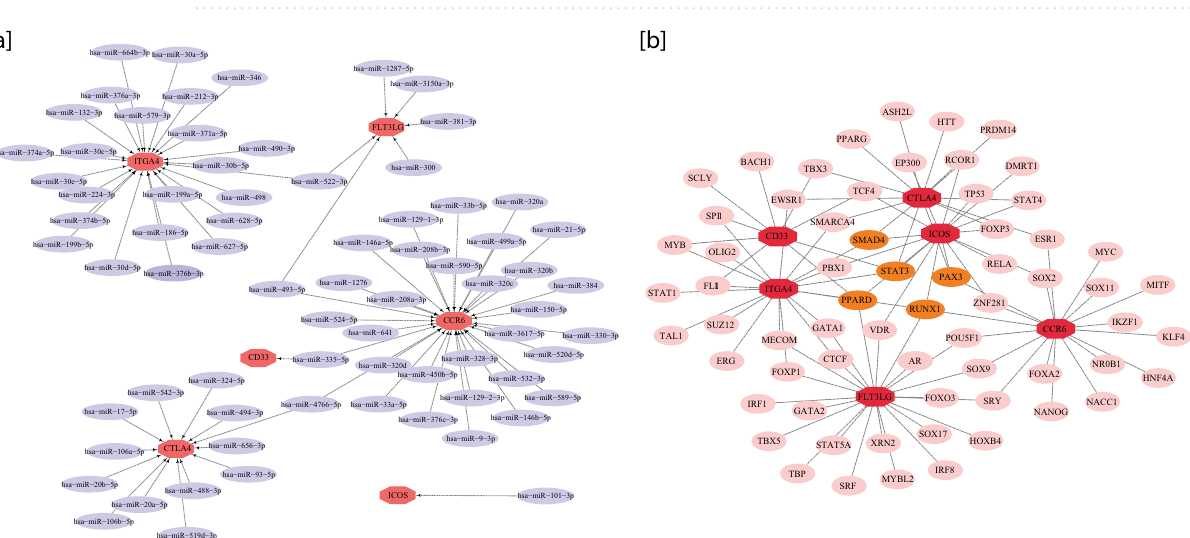
Figure 7. Comparison to the Hamiltonian energy of the original (black) and the corresponding key regulators knockout network (red) at various levels of organization of the SARC network.